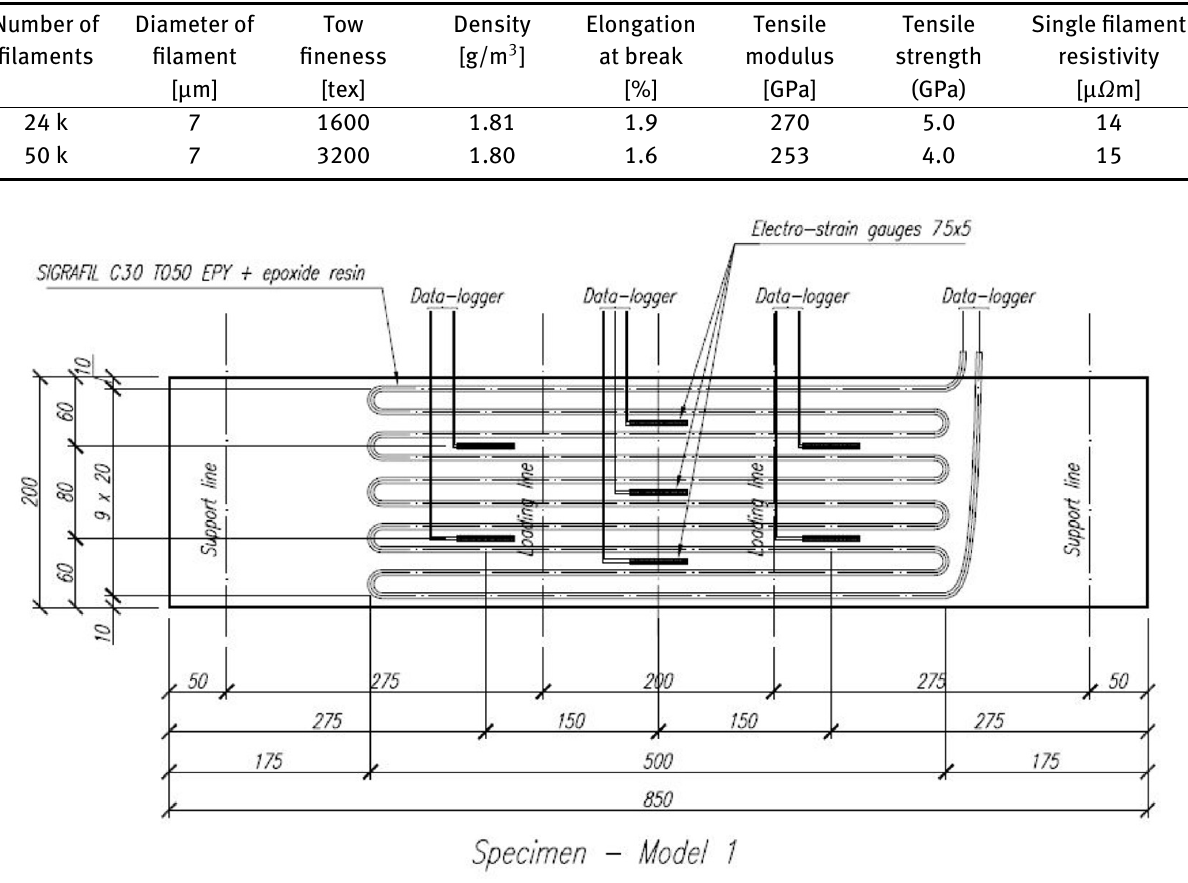
Figure 1: Scheme of the initial tests on specimens SP1 and SP2 equipped with the strengthening solution with the use of conductive carbon fibres